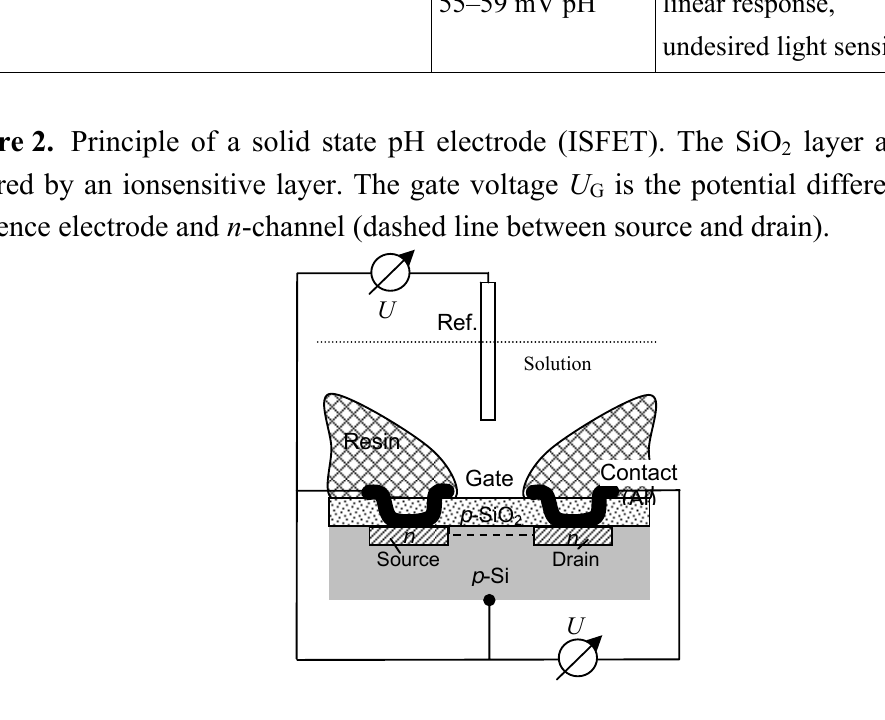
is the potential difference between G